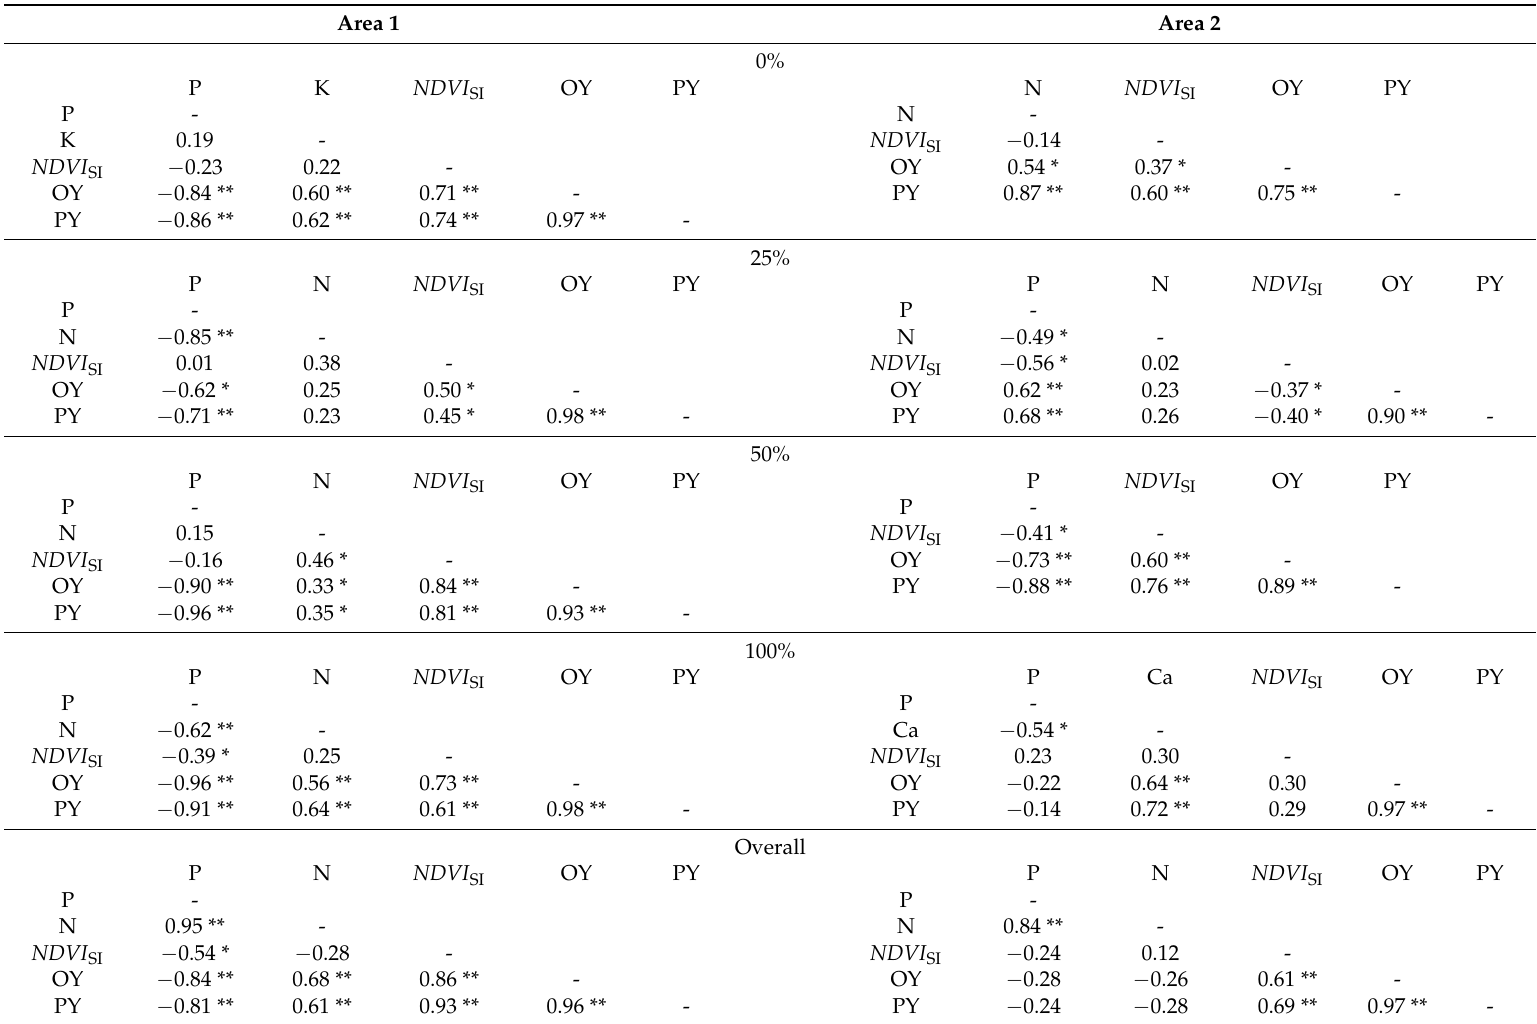
Table 5. Correlation matrix between observed and predicted sugarcane yield values with selected variables with stepwise